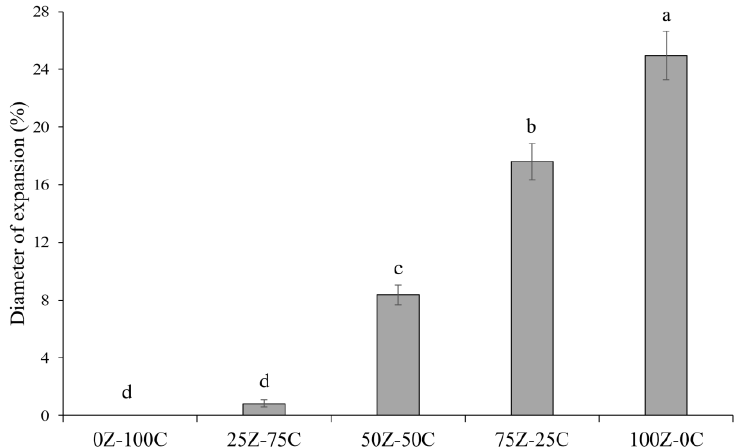
Figure 6. Schreiber meltability test of plant-based cheese alternative samples. Different letters (a–d) indicate significant differences between samples ( p < 0.05).